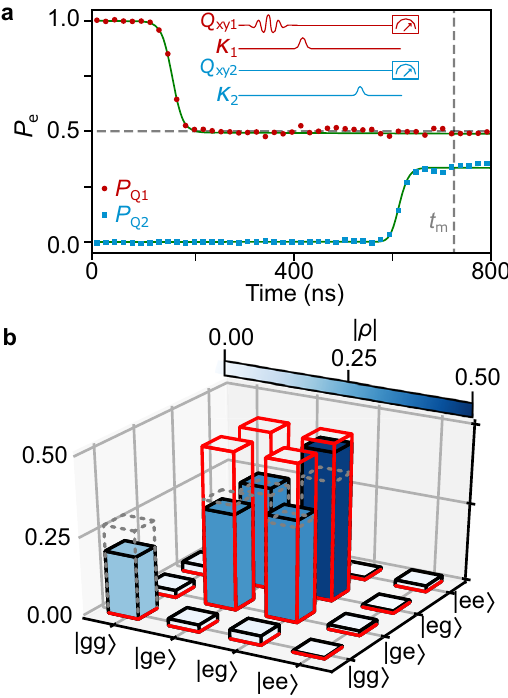
Fig. 3 Phonon-mediated Bell state generation. a Inset: pulse sequence for Bell state generation. Main panel: excited state probabilities for Q 1 (red) and Q 2 (blue) as a function of time. Green lines are results from a master equation simulation. The fi nal state is Fig. 2 Phonon-mediated quantum state transfer and process analyzed at t m = 725 ns (gray dashed line). b Bell state density matrix, absolute values, without readout correction, measured at t m . tomography. a Measured Q 1 excited state population P Q 1 as a e Red solid lines show values expected for an ideal Bell state; black function of time and Q 1 bare frequency, with coupler G 1 at an dashed lines show simulation results including qubit coherence and intermediate coupling κ 1 /2 π = 2.4 MHz (measured at 3.976 GHz) and phonon channel G 2 set to zero coupling. In this con fi guration, Q 1 ’ s energy relaxation is dominated by phonon emission via UDT 1 , followed by traveling phonon dynamics. The white and red dashed lines indicate the unidirectional and bidirectional working frequencies, respectively (see text); inset shows the qubit excitation and measurement pulse sequence. b Quantum state transfer via a traveling phonon at the unidirectional (left) and bidirectional (right) operating frequencies. Q 2 ’ s fi nal population is 4.5 times smaller for the bidirectional transfer compared to the unidirectional transfer, in line with simulations. Green solid lines are from a master equation simulation. Inset: pulse sequence. For either process, Q 1 ’ s emission rate is set to κ uni j bi = 2 π ¼ 10 j 6 MHz , corresponding to a 81 ∣ 138 ns full-width-at- c half-maximum (FWHM) phonon wave packet. c Quantum process tomography for the unidirectional and bidirectional regimes, with (cid:3) χ Þ ¼ 82± 0 : 3 % and process fi delities of F uni ¼ Tr ð χ exp ideal ¼ 39± 0 : 3 % , respectively. Red solid lines show values expected F bi for an ideal transfer; black dashed lines show master equation simulations, taking into account fi nite qubit coherence and phonon channel losses. Uncertainties are standard deviations from the mean.